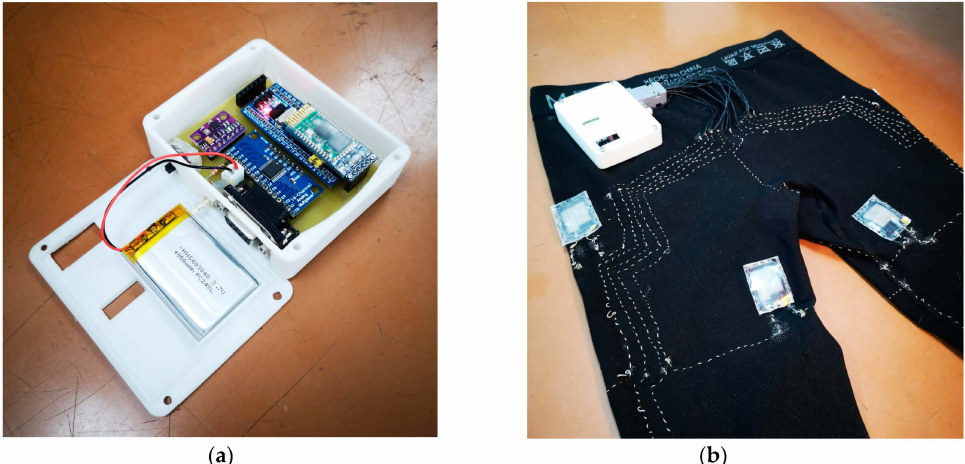
Figure 3. ( a ) Acquisition card in a 3d-printed case; ( b ) Location of the acquisition board on the expandable fabrics